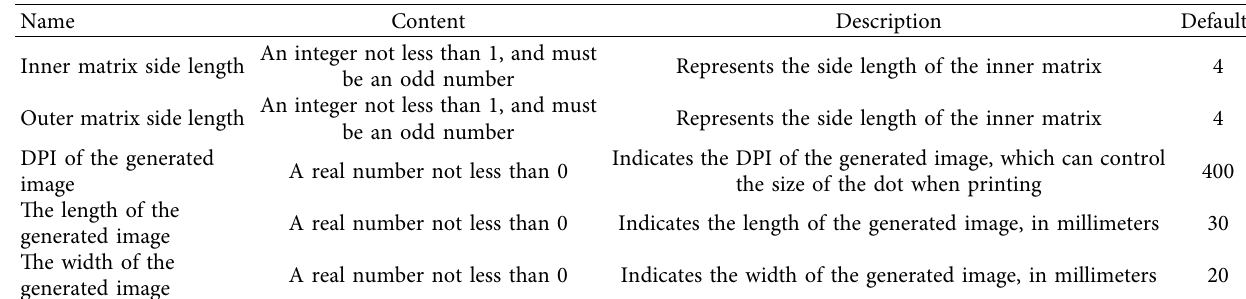
Table 1: Specific parameter information.